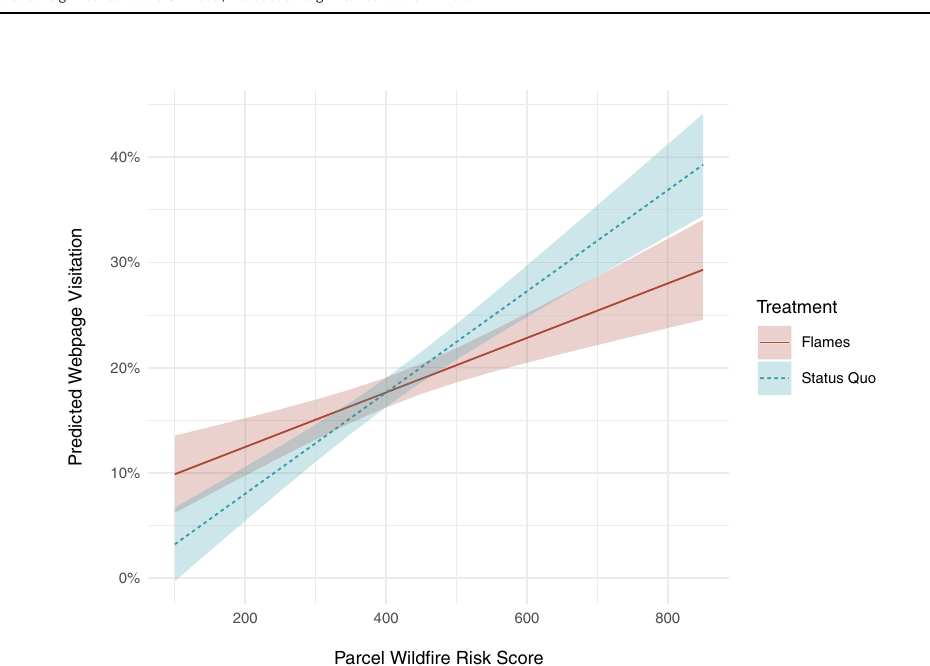
Fig. 3 Predicted webpage visitation by property-level wild fi re risk and photo treatment. Solid red line represents predicted visitation in response to the fl ames photo; dashed blue line represents predicted visitation in response to the status quo photo. Shaded ribbons represent the 95% con fi dence intervals for the predicted values.